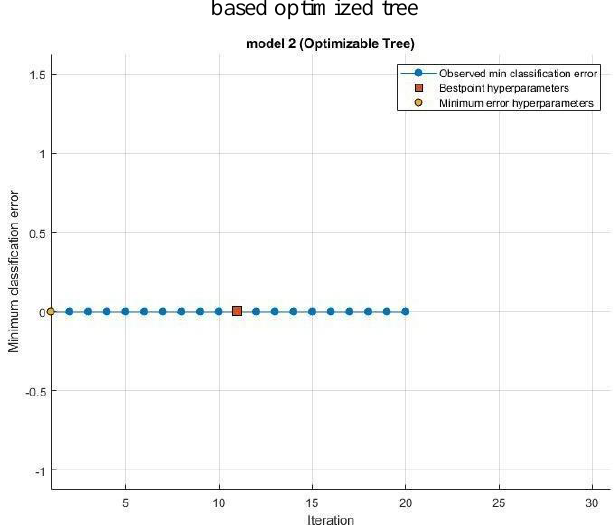
Fig. 16. OS scan minimum classification error of grid search based optimized tree